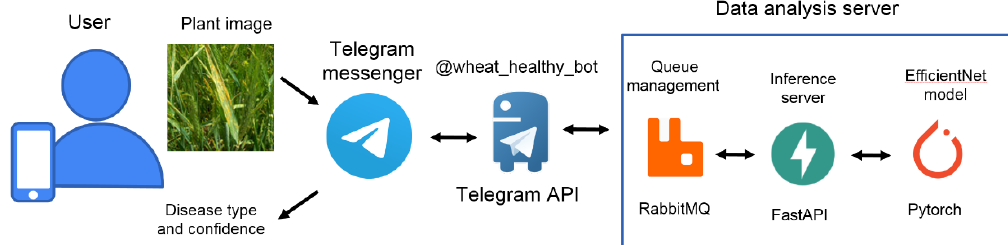
Figure 4. The implementation of the Telegram chatbot for prediction of the wheat fungal diseases. From left to right: user inputs plant image via Telegram messenger; @wheat_healthy_bot provides interface for the data analysis server by using Telegram API; Queue manager controls the Inference server load; Inference server performs wheat image classification using EfficientNet neural network model.